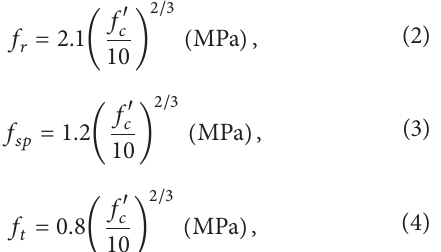
Figure 4: Particle size distributions of the coarse and fine aggregate.